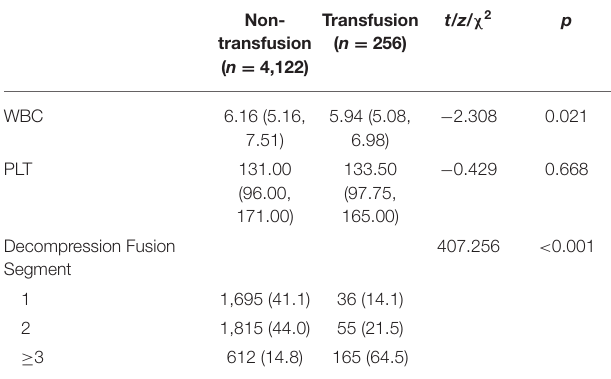
TABLE 1 | Comparison of demographic and preoperative data of the two groups of